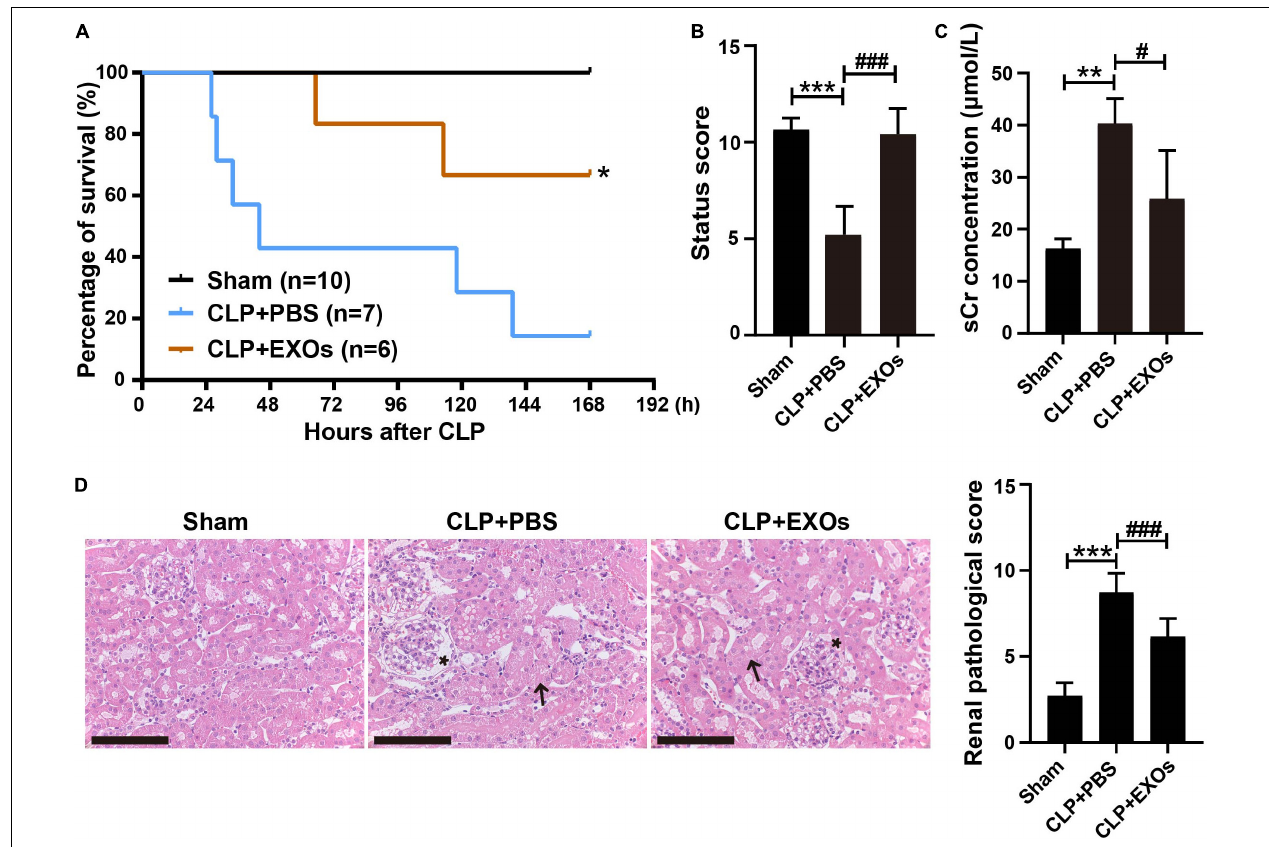
FIGURE 5 | hAECs-derived exosomes (EXOs) reduced the mortality of septic mice and ameliorated kidney damage. (A) EXOs reduced the mortality of septic mice. * P < 0.05 vs. the CLP + PBS group. (B) Assessment of the clinical signs of mice at 16 h after CLP. *** P < 0.001 vs. the sham group; ### P < 0.001 vs. the CLP + phosphate-buffered saline (PBS) group. (C) Serum creatinine concentration in mice 16 h after CLP with PBS ( n = 5) or EXOs ( n = 5) injection. ** P < 0.01 vs. the sham group; # P < 0.05 vs. the CLP + PBS group. (D) Renal pathology of septic mice kidney at 16 h after CLP or CLP with EXOs treatment and renal pathological scoring. Representative micrographs from each group are shown. The arrows indicate tubular epithelial vacuolization and the loss of brush border and the asterisks indicate Bowman’s capsule expansion (H&E staining; scale bar = 50 µ m). The lesions in the kidney were alleviated by the EXOs treatment. *** P < 0.001 vs. the sham group; ### P < 0.001 vs. the CLP + PBS